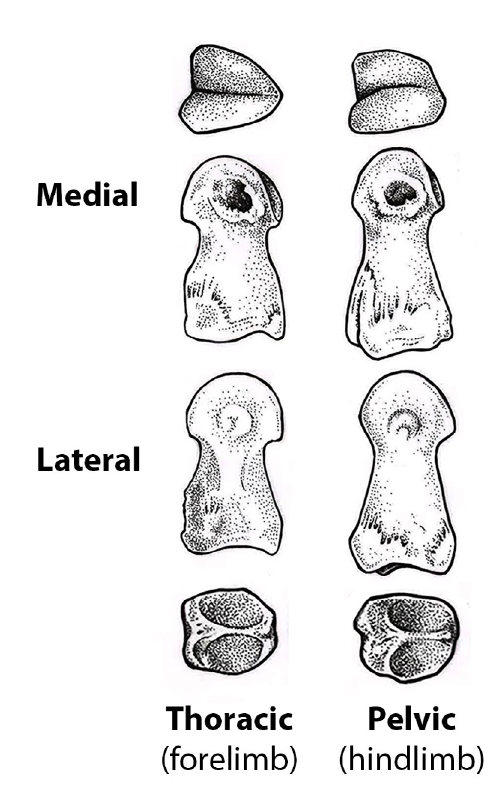
Figure 4. PII (Reverse anatomical position). Illustra- tion by